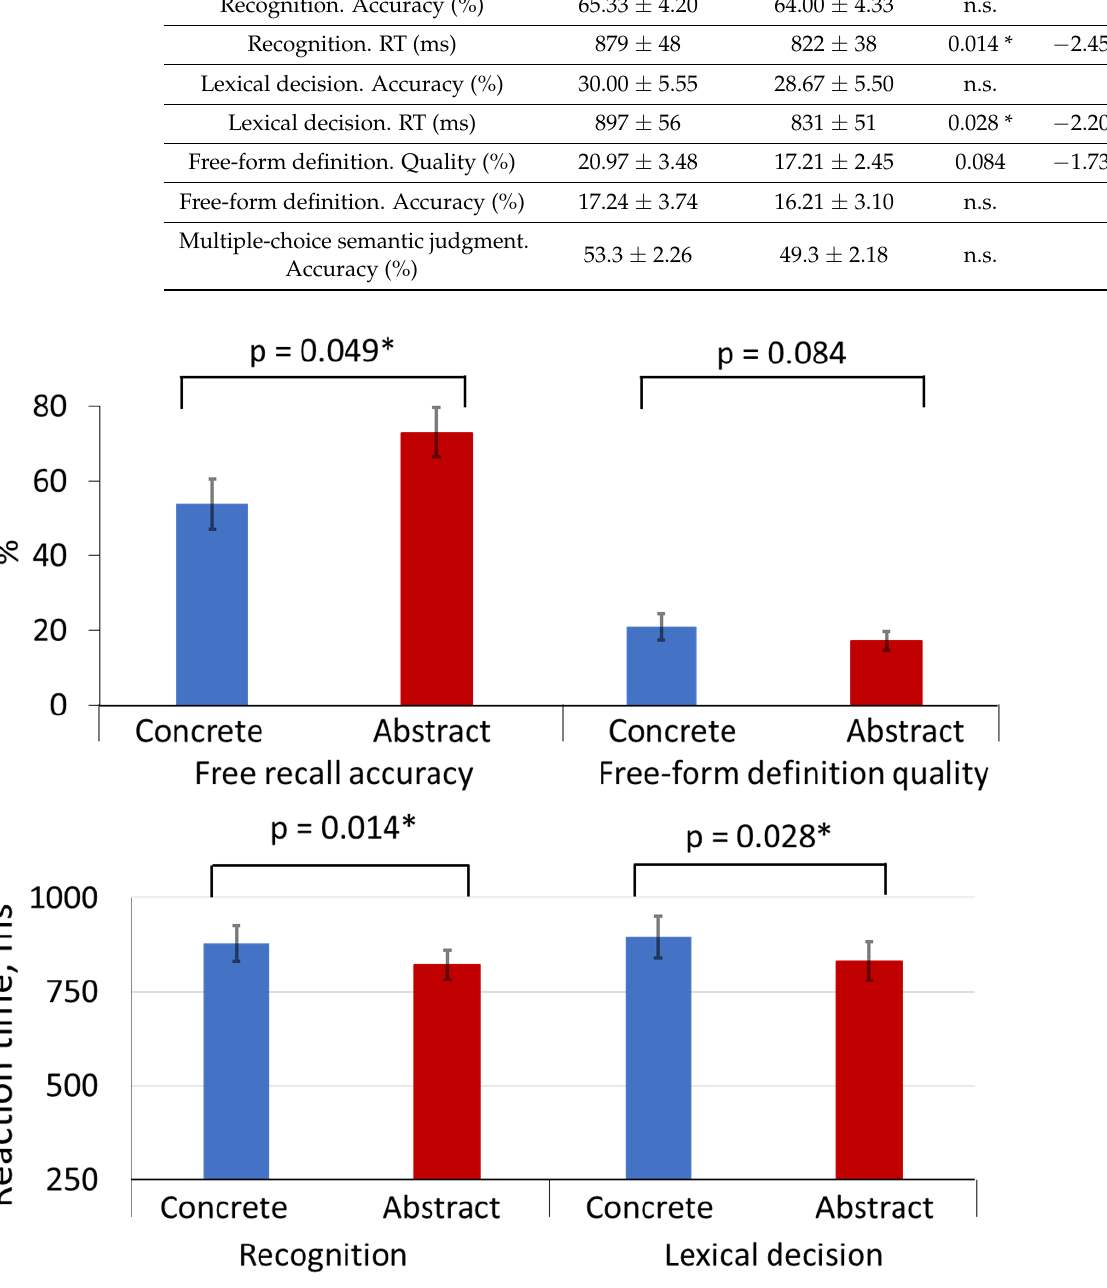
Figure 3. Behavioural results for novel concrete (blue) and abstract (red) words, significant on 0.05 (*) and 0.1 levels. Comprehensive analysis of these data revealed better performance for abstract vs. concrete words manifested as significantly higher accuracy in the free recall task ( p = 0.049, Z = −1.972) and shorter reaction times in both recognition ( p = 0.014, Z = −2.454) and lexical decision tasks ( p = 0.028, Z = −2.201). Concrete words, in turn, showed higher definition quality than abstract words, but only at the level of tendency ( p = 0.084, Z = −1.731). Accuracy of recognition, lexical decision, and multiple-choice semantic judgment tasks did not show any significant differences between the two groups of novel words.